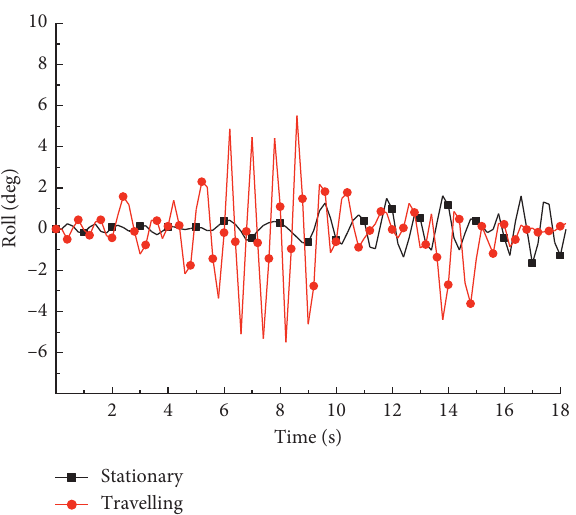
Figure 10: Time history curve of ship roll in landslide